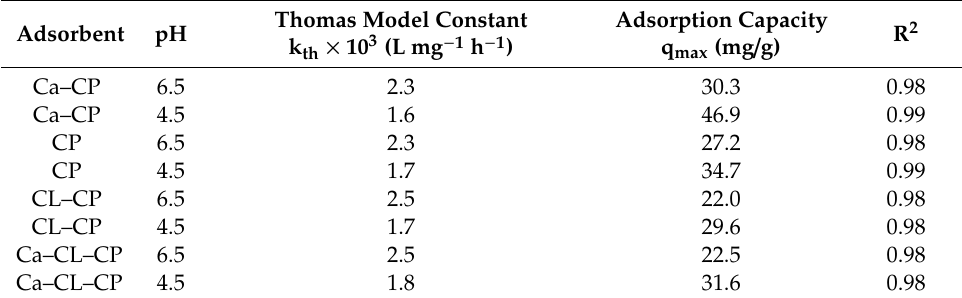
Table 2. Thomas model constants for different adsorbents.